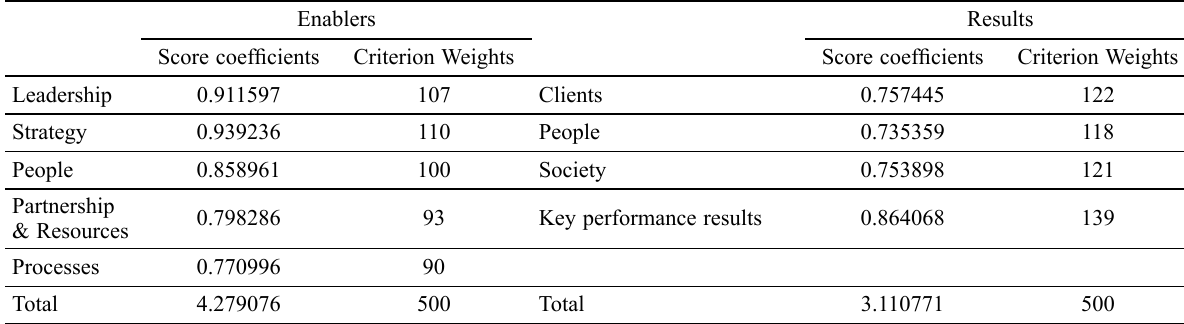
Table 10. Component score coefficients and criterion weights